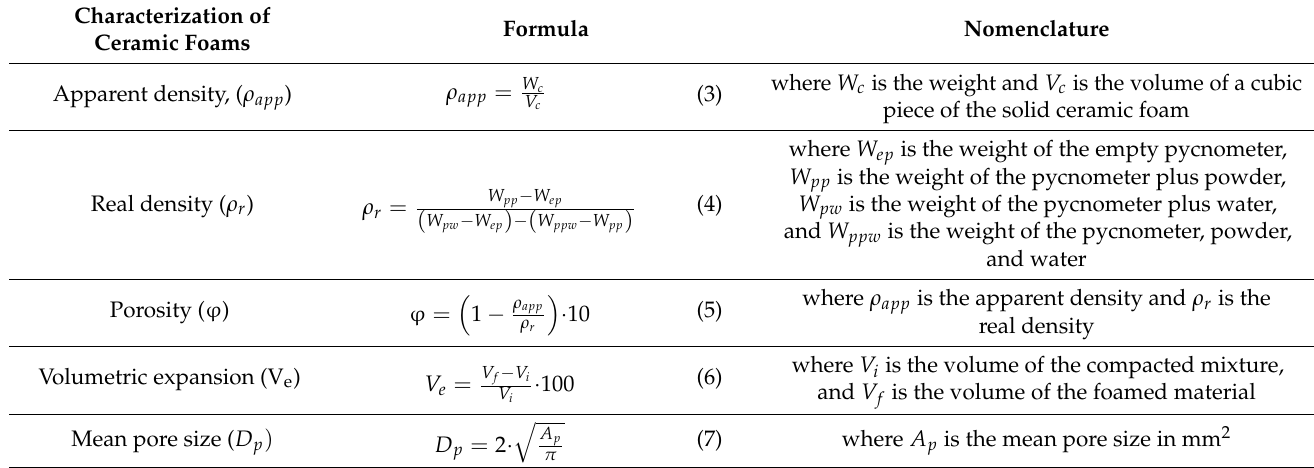
Table 3. Equations used for the characterization of ceramic